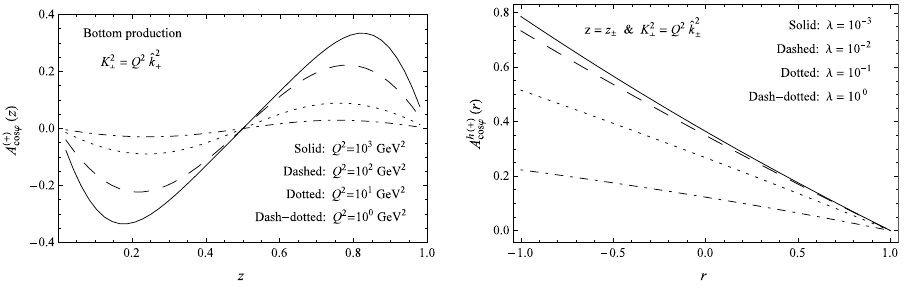
Figure 4. Left panel: cos ϕ asymmetry due to the contribution of unpolarized gluons only, A ( + ) A cos ϕ ( z , K ⊥ = Q 2 ˆ k 2 + ), as a function of z at several values of Q 2 . Right panel: cos ϕ asymmetry with the contribution of linearly polarized gluons, A h ( + ) cos ϕ ( r ) ≡ A h several values of